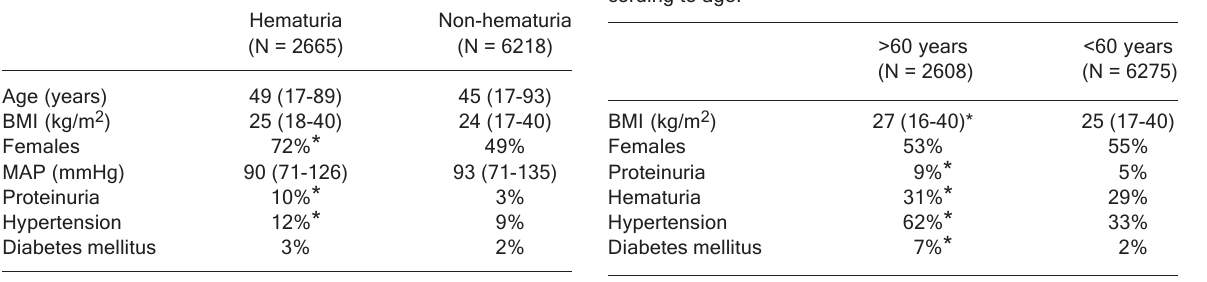
Table 4. Clinical characteristics and dipstick abnormalities ac- cording to age.